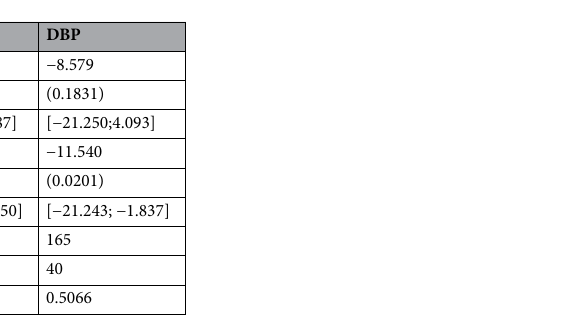
Figure 4. Panel ( A ) depicts the coefficient estimates and 95% CI from Eq. (1) at different bandwidths. The data-driven optimal bandwidth for BMI, SBP and DBP is ± 64, ± 40, and ± 40 CD4 cells/μl, respectively. Panel ( B ) depicts the coefficient estimates and the 95% CIs from estimating Eq. (1) with addition of an quadratic function of the deviation. For comparability, the optimal bandwidth of the linear specification is used. The optimal quadratic bandwidths would be ± 100, ± 80 and ± 85, respectively. Results are robust to the employment of the optimal bandwidth for the quadratic specification.